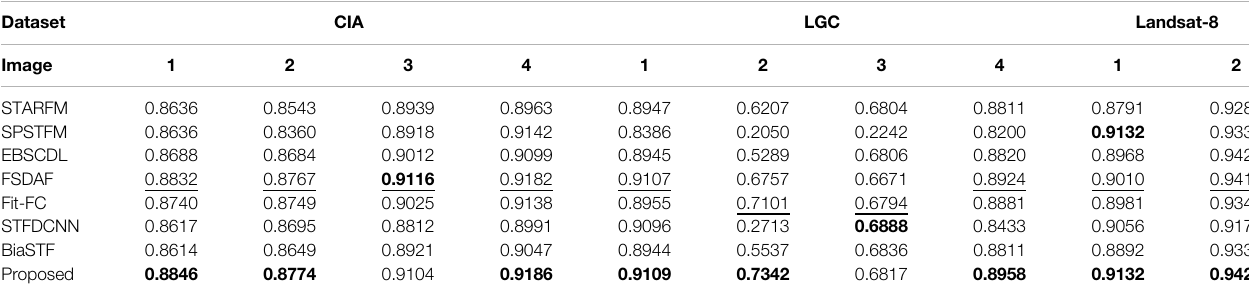
TABLE 10 | Q4 evaluation of spectral inconsistency